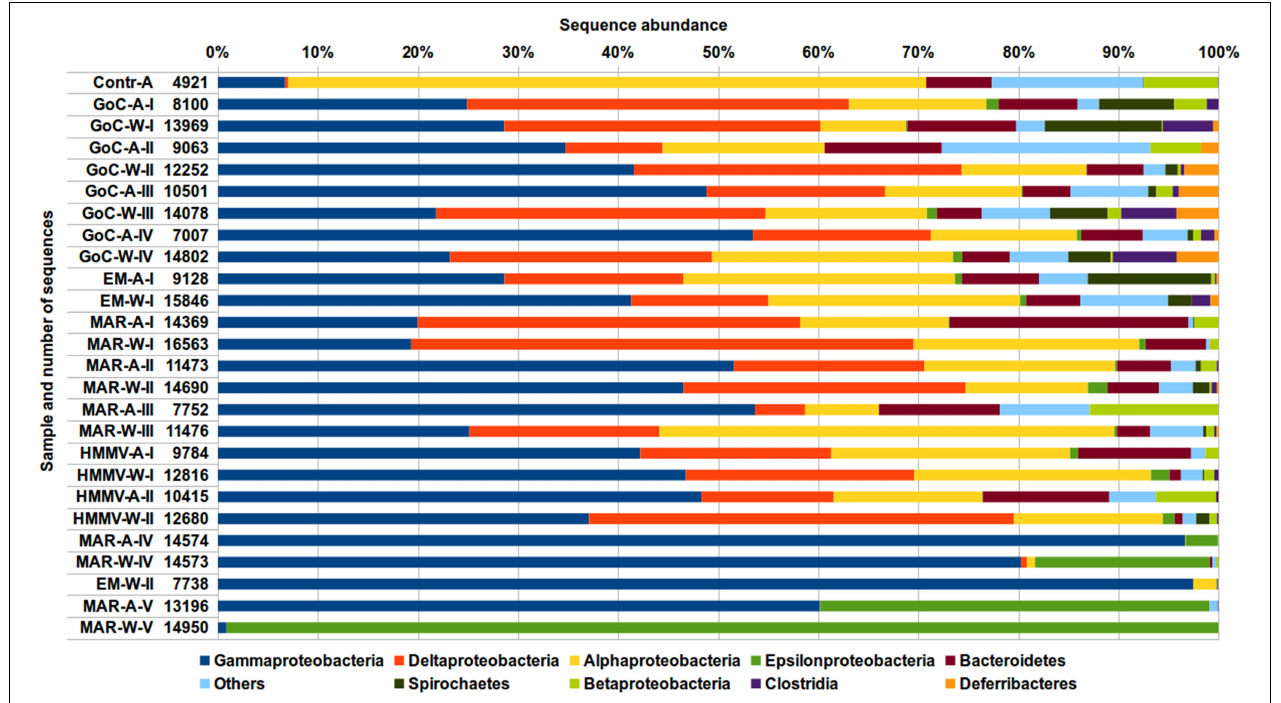
FIGURE 2 | Composition of bacterial communities at the division or sub-division level based the on V5-V6 region of 16S rDNA gene sequences (OTU identity threshold at 97%). Please refer